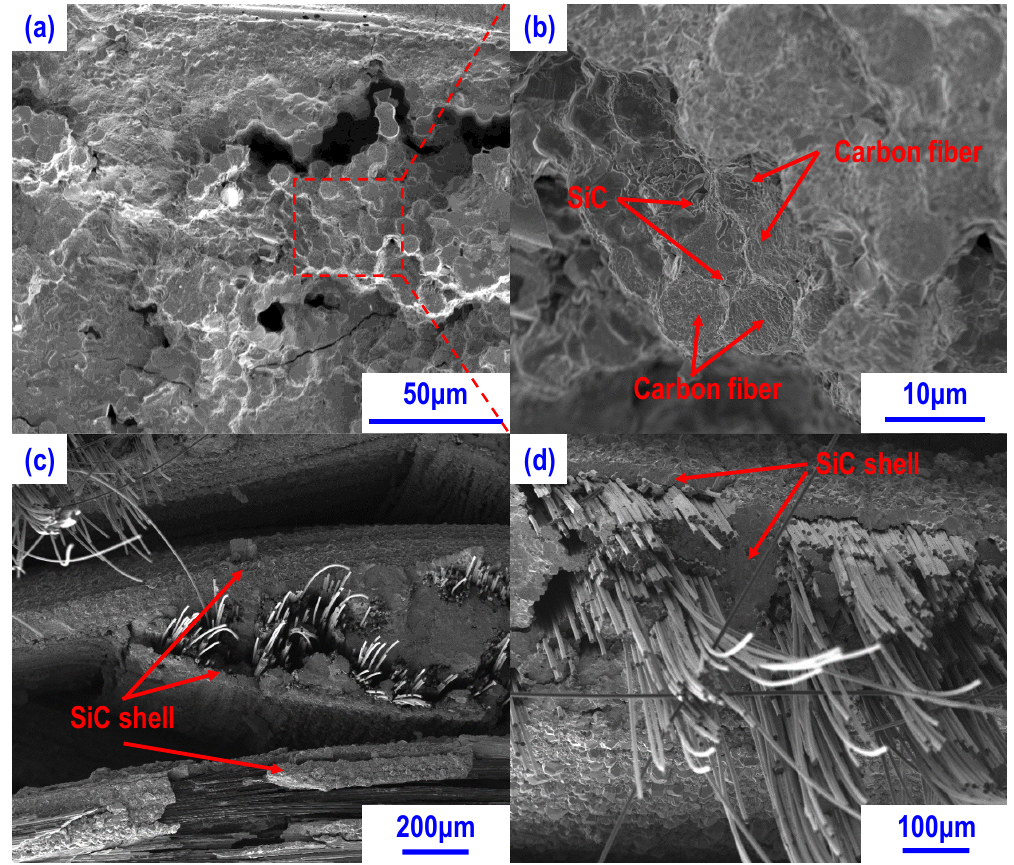
Figure 9. Microstructure of composites after flexural test under vacuum at 1600 °C: ( a ) CSZ0 showing the flat fracture surface almost no fiber pulled out; ( b ) high magnification image showing the closely bonded carbon fibers by the SiC formed during mechanical test; ( c ) microstructure of CSZ10 showing the SiC shell around carbon fibers; ( d ) high magnification image showing the pulled out carbon fibers wrapped with the SiC shell.